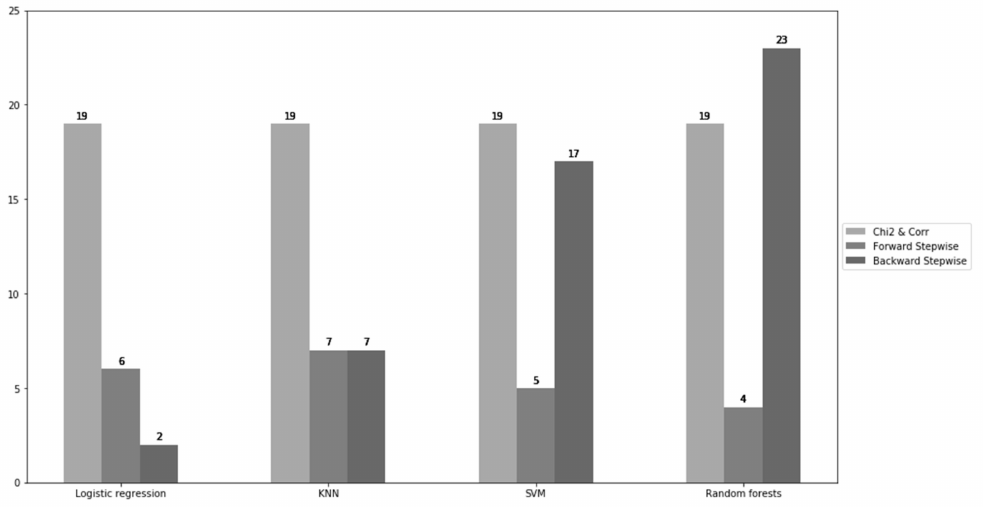
Figure 5. The number of selected